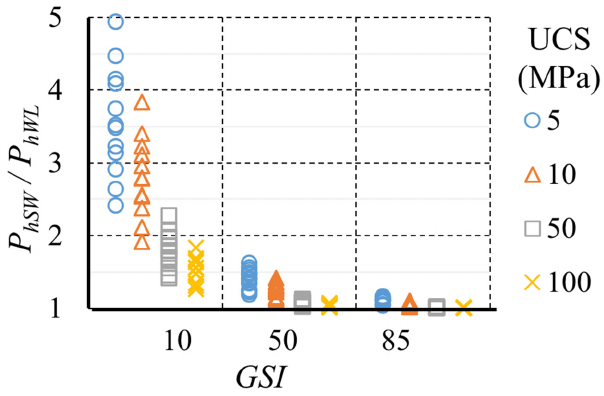
Figure 13. Correlation between P hSW and P hWL depending on GSI and UCS .